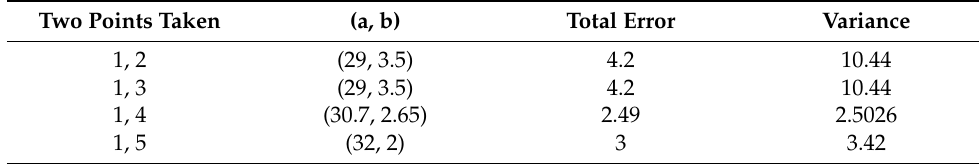
Table 5. Relevant parameters of linear